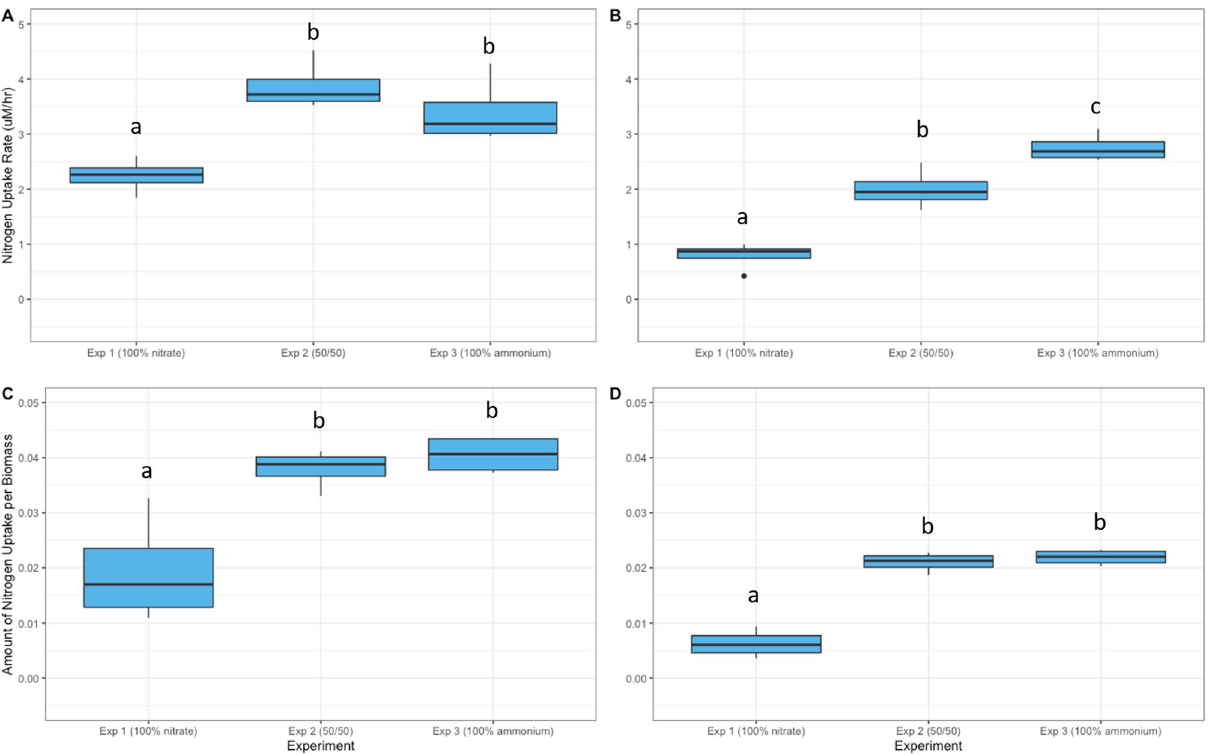
Figure 4. Assimilation of NO for Heterosigma akashiwo . Nitrogen uptake rate ( A , B ) and amount of nitrogen uptake per biomass ( C , D ) at 4 h ( A , C ) and 24 h ( B , D ) after spiking with 15 NO for Heterosigma akashiwo cultures when acclimated to growth on 100 µM nitrate (Exp 1), 50 µM nitrate and 50 µM ammonium (Exp 2), or 100 µM ammonium (Exp 3). Error bars are + /− 1 standard deviation from the mean. Significant difference in the 15 N-nitric oxide uptake rate and amount of 15 N-nitric oxide uptake per biomass between experiments is denoted (a, b,